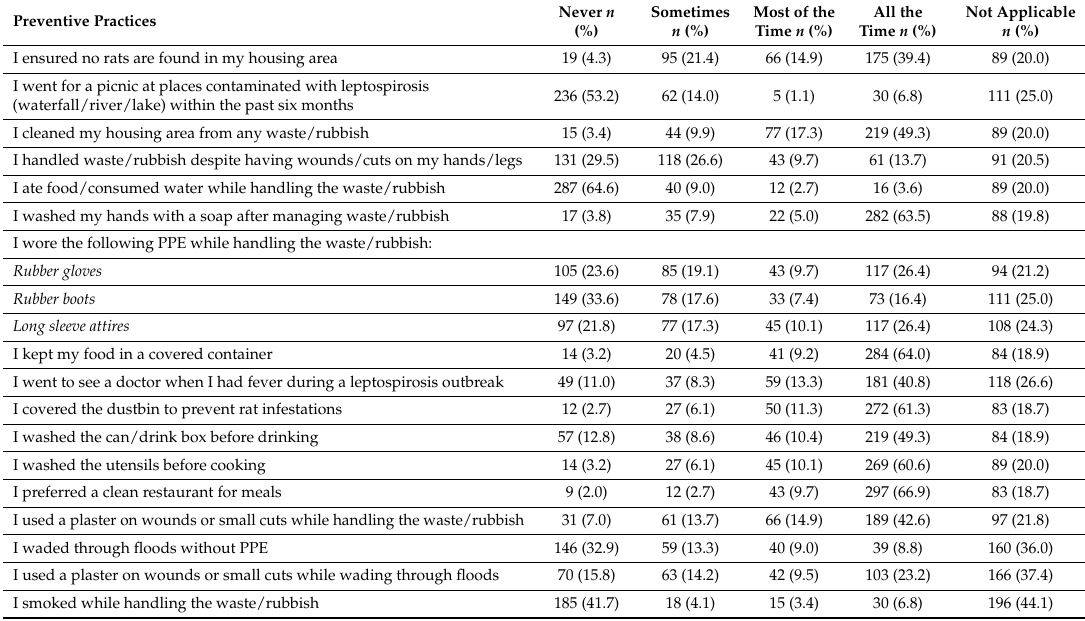
Table 3. Preventive practices on leptospirosis among rural communities in Hulu